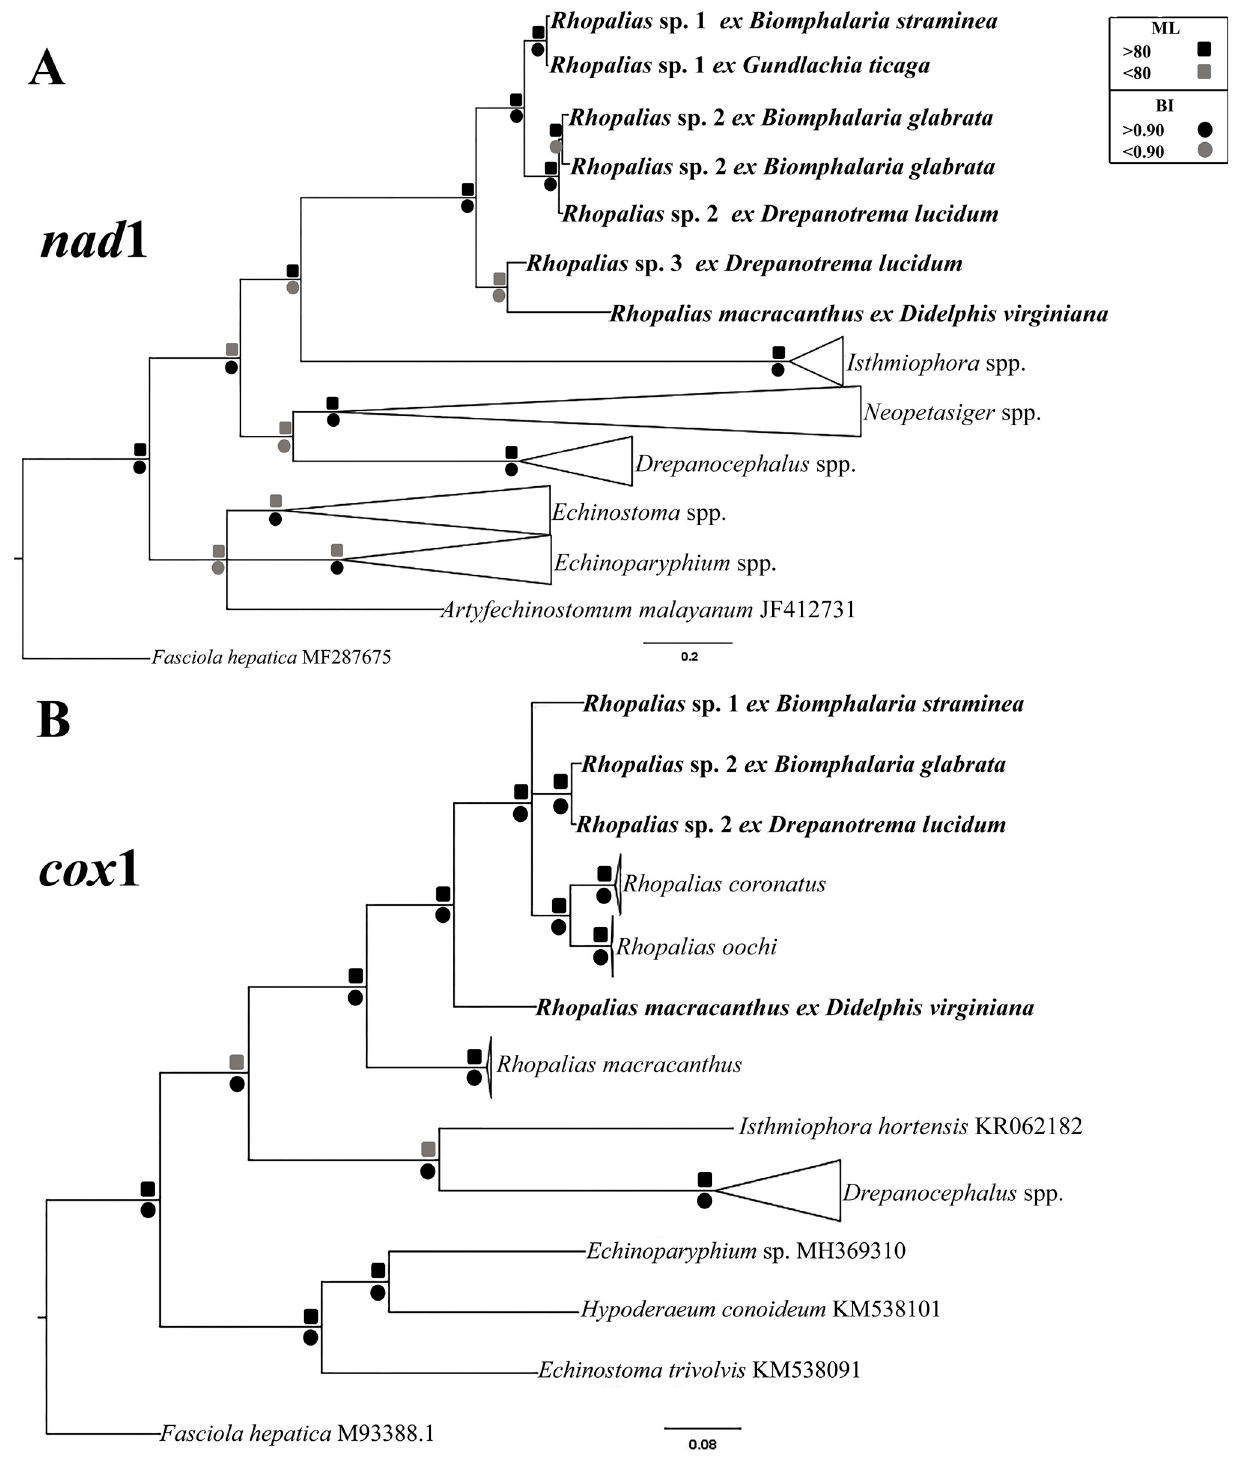
Fig 3. Phylogenetic relationships between Rhopalias spp. found in planorbids from Brazil and members of the family Echinostomatidae inferred from (A) nad 1 (397 bp) and (B) cox 1 (612 bp) sequence data. The trees were generated by Bayesian Inference (BI) and Maximum Likelihood (ML) methods. New sequences from the present study are in bold. Scale bar represents the number of nucleotide substitutions per site.